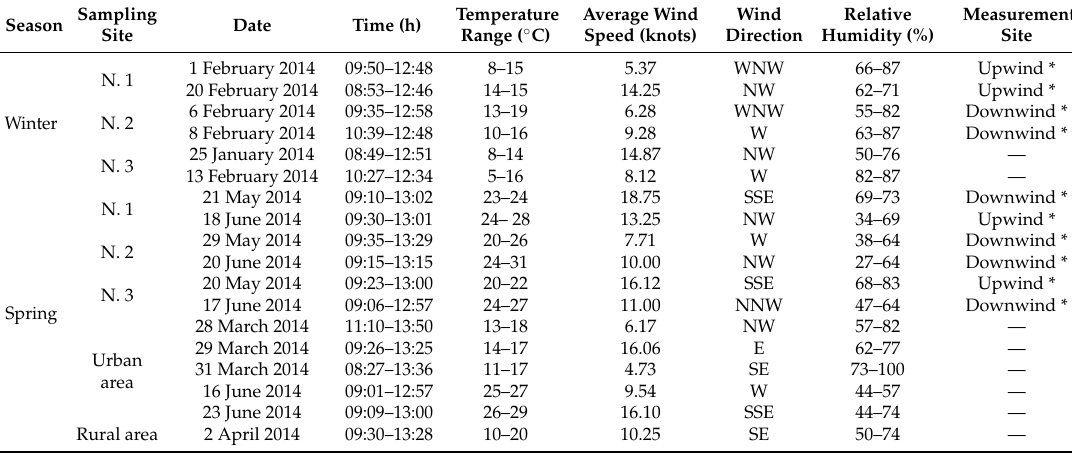
Table 1. Measurement times and meteorological data during each sampling (nearby airport, urban, and rural area).